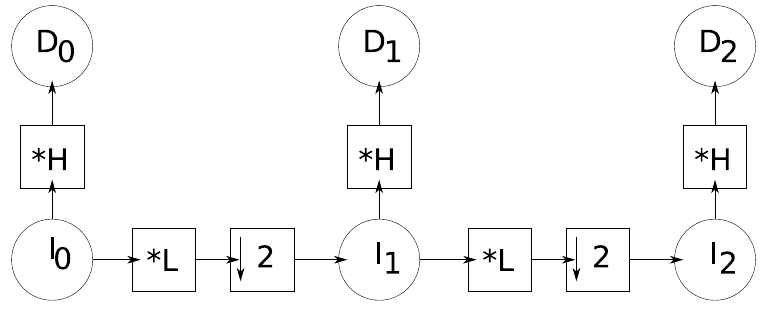
Figure 2. Illustration of the creation of a pyramid with three